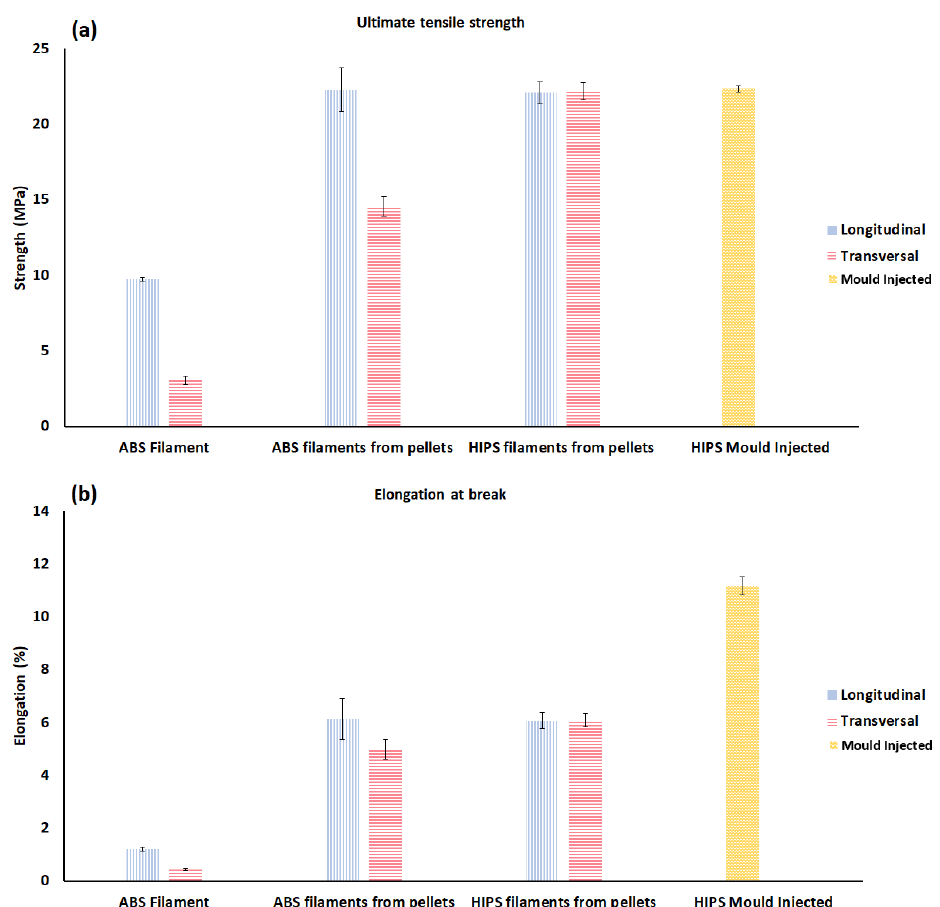
Figure 3. Tensile test results: ( a ) Ultimate tensile strength, and ( b ) Elongation at the break, in which the error bars represent the standard deviation of the samples. Reprinted with permission from Ref. [16]. 2019, GCSTMR.